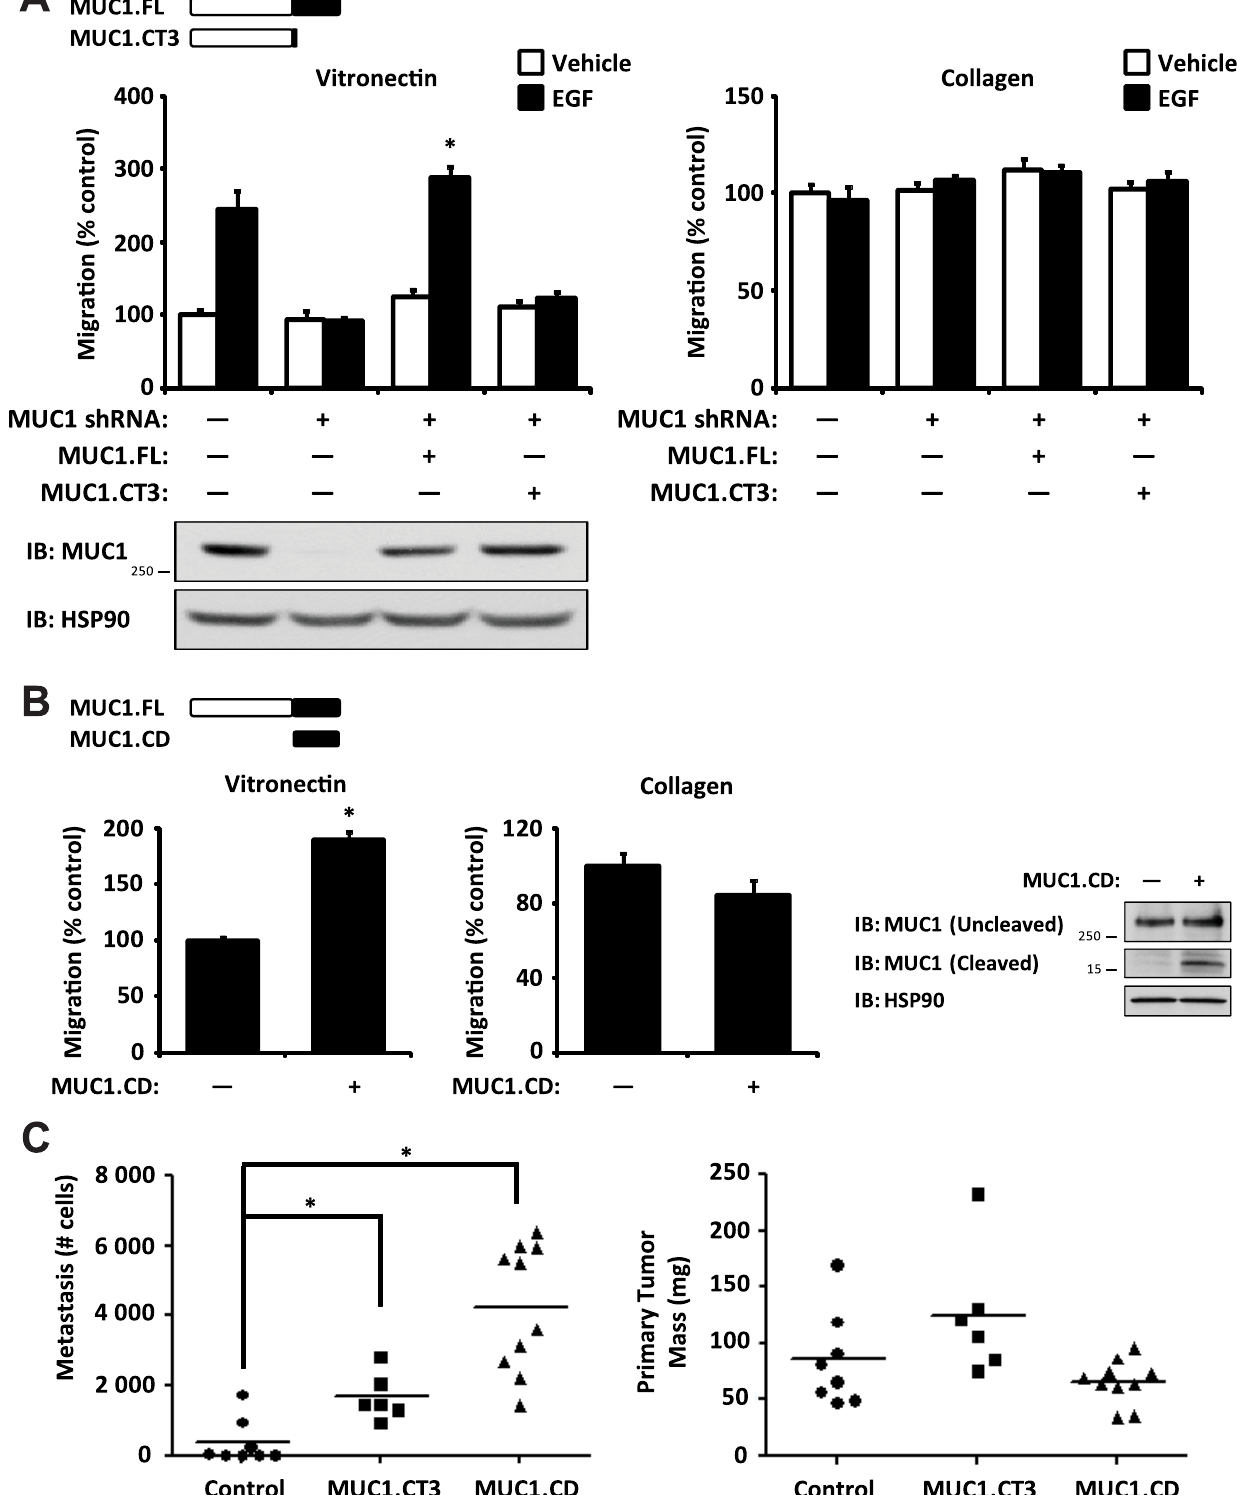
Figure 4. MUC1 cytoplasmic domain is necessary and sufficient for migration and metastasis. ( a ) Migration assays on a vitronectin (left) or a collagen (right) substrate comparing FG cells co-expressing MUC1 shRNA and shRNA-resistant full-length MUC1 (MUC1.FL) or cytoplasmic domain-deleted MUC1 (MUC1.CT3) with or without a 15 minute pre-treatment of EGF. Cells were washed with PBS prior to inoculation on Boyden chambers to remove EGF. Schematic (top) illustration of MUC1.FL and MUC1.CT3 protein products including ectodomain (white) and cytoplasmic domain (black). Immunoblot detecting MUC1 expression with Cell Signaling Technology anti-MUC1 clone VU4H5 (bottom). P , 0.0001 comparing